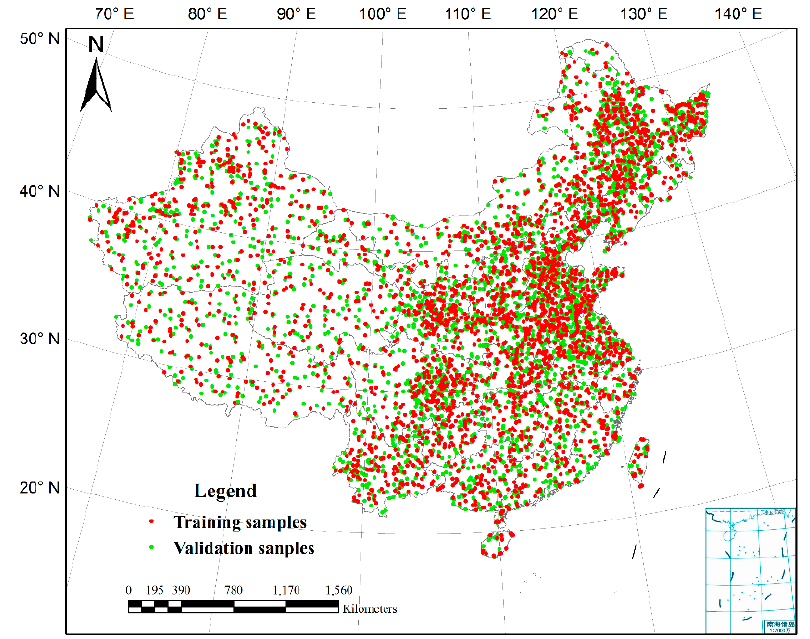
Figure 1. Training and validation samples.